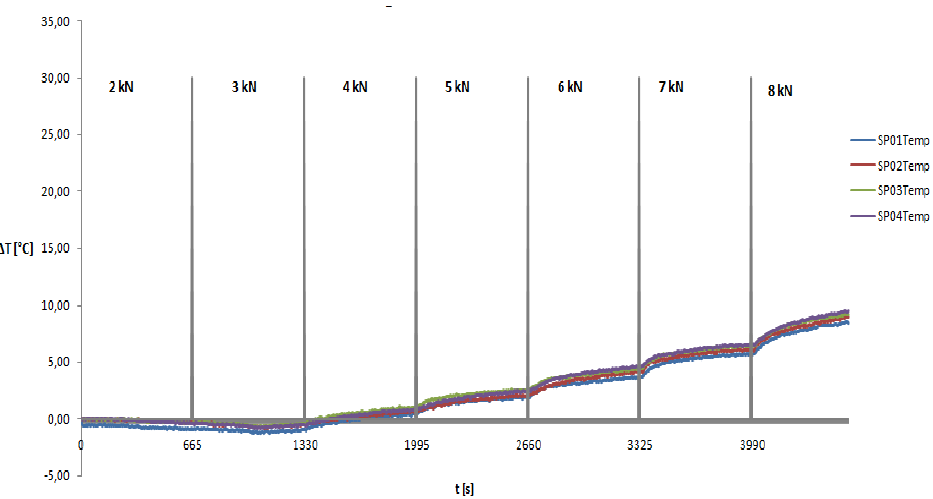
Figura 9: profilo termico per la prima serie di